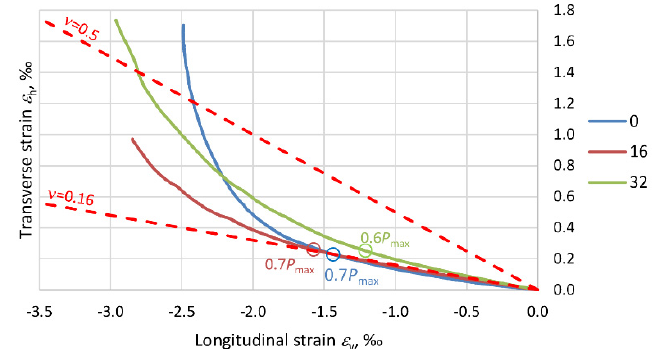
Figure 14. Graphs showing the variation of Poisson’s ratio ν for columns C_1H.